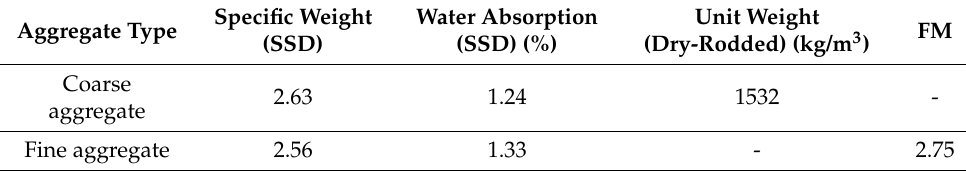
Table 3. Physical properties of the aggregates.